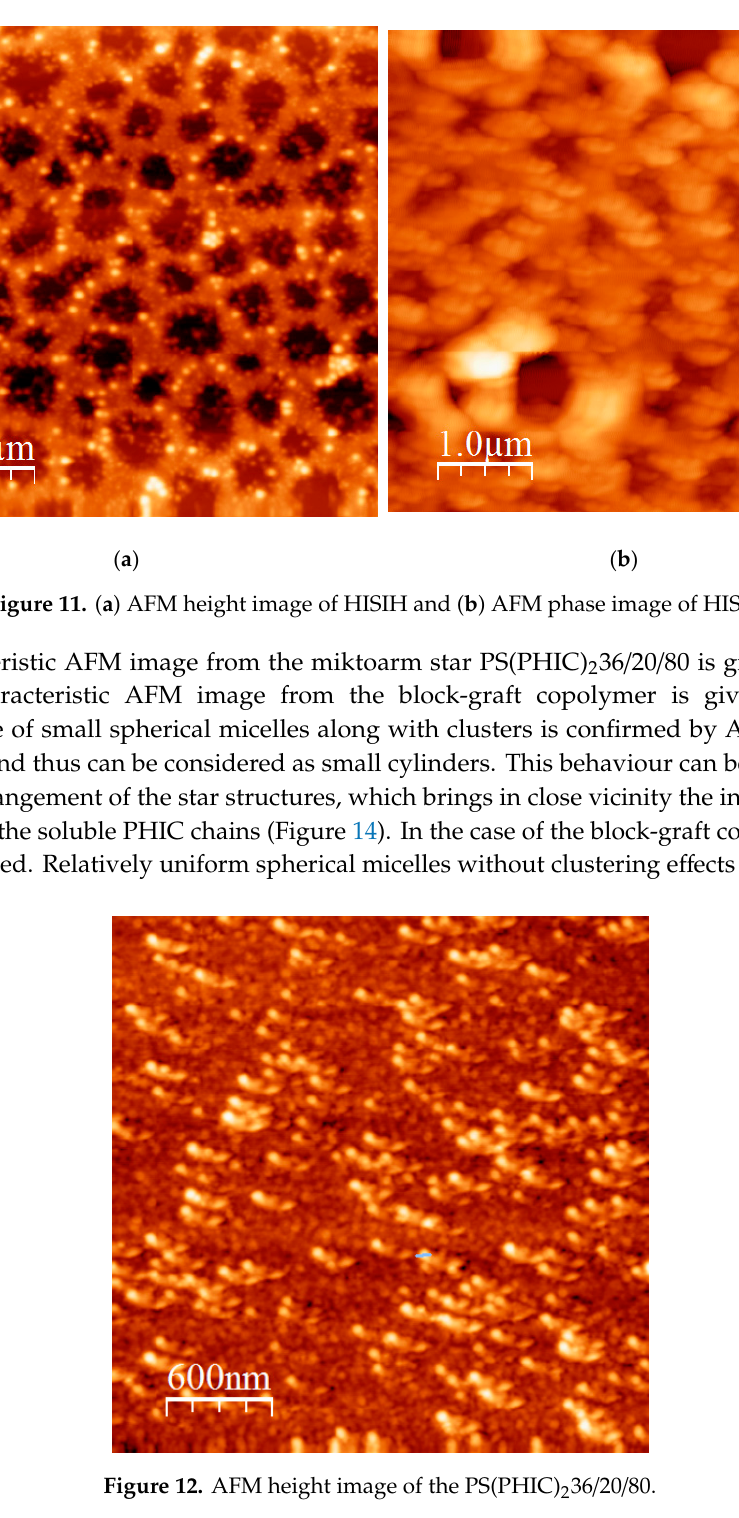
Figure 13. AFM height image of the block-graft copolymer. Figure 14. Schematic illustration of the cylindrical aggregates from the interaction of the initially formed spherical micelles. 4. Conclusions The micellization behaviour of various macromolecular architectures, involving diblock and triblock copolymers, pentablock terpolymers, miktoarm star copolymers and block-graft terpolymers, based on poly(hexyl isocyanate), PHIC, was studied in this work. n-Heptane, which is